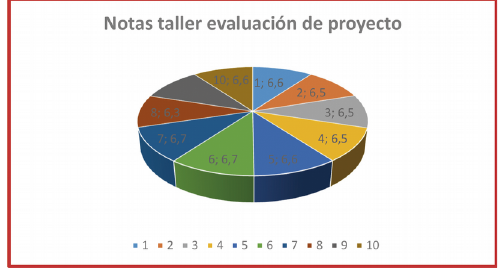
Figure 23. Project evaluation workshop grades of the 10 students (Where 1;6,6 means Student;